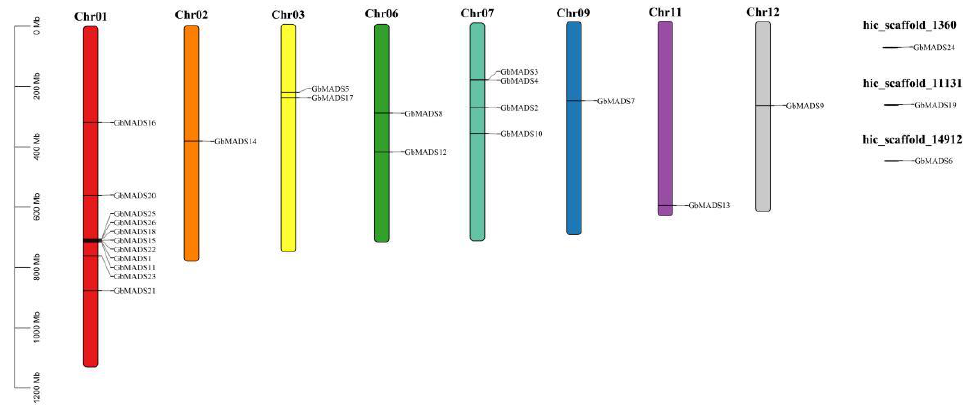
Figure 1. Chromosome location of GbMADS gene family in G. biloba . Each chromosome is marked with different colors. The length of chromosomes can be estimated by the scale on the side.